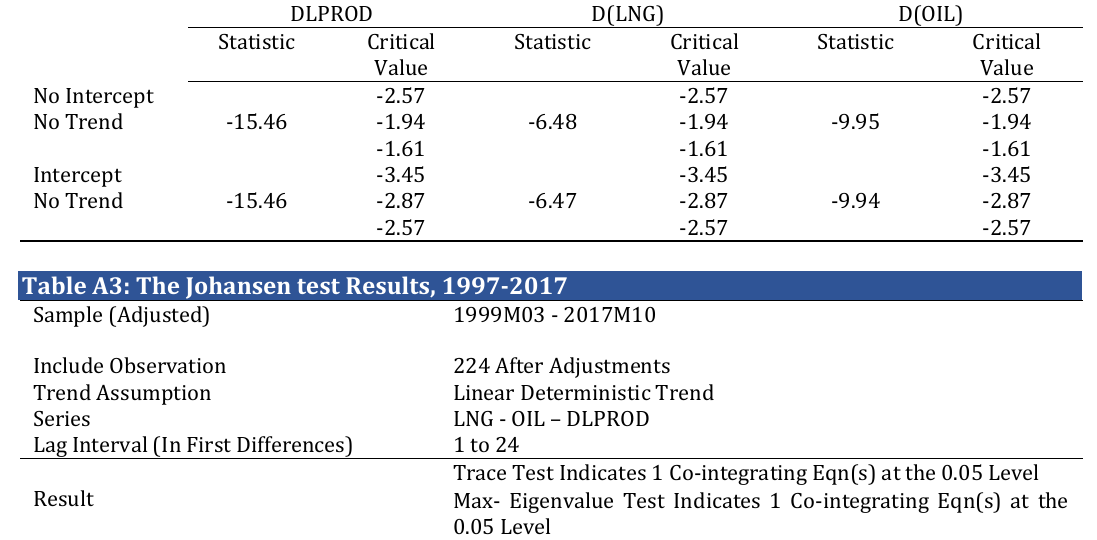
Table A2: The ADF test Results, 1997-2017